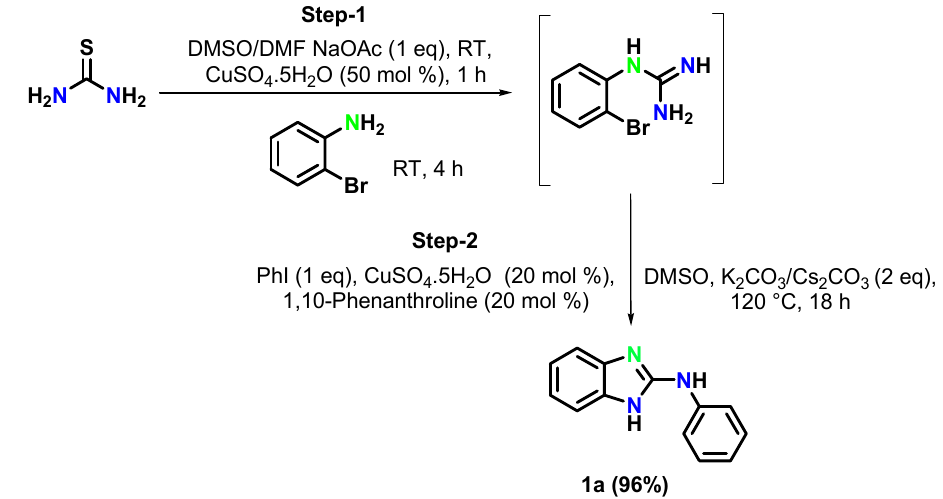
18 CuSO 4 · 5H 2 O K 2 CO 3 d 120 L4 52 19 - K 2 CO 3 120 L4 n.d. f - a Reaction conditions: Step-1: Thiourea (1 mmol); DMSO / DMF (2 mL); NaOAc (1 equiv); copper salt (50 mol%), 1 h, room temperature; 2-bromo aniline (2 mmol), room temperature, 4 h; Step-2: iodo benzene (1 mmol); copper salt (20 mol%); ligand (20 mol%); base (2 mmol) 18 h,temp; b Cs 2 CO 3 (2.0 equiv); c copper salt (10 mol.%); d K 2 CO 3 (1.0 equiv); e conversion based on diagnostic peaks integration in 1 HNMR of crude reaction mixture; f n.d. = not detected; g isolated yield.